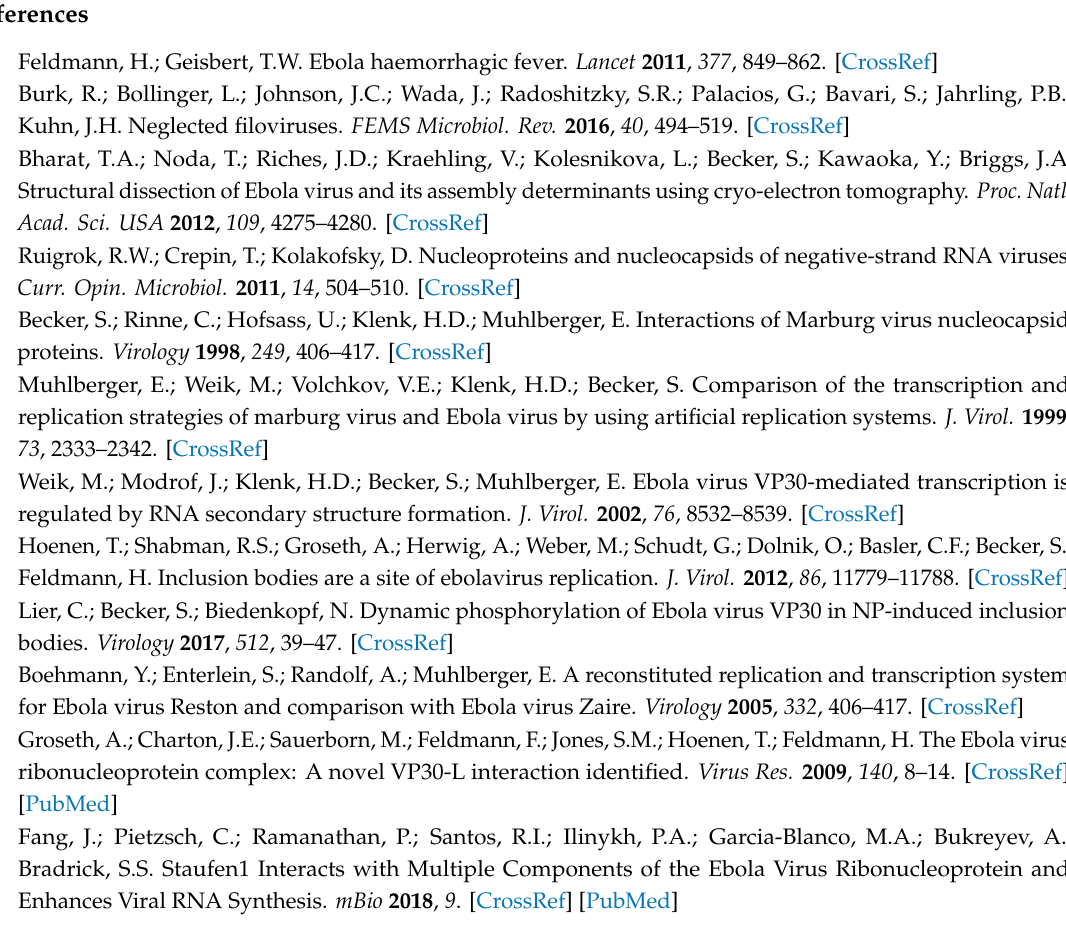
Figure S1. Comparison of T7 and Pol-II-driven replication-deficient